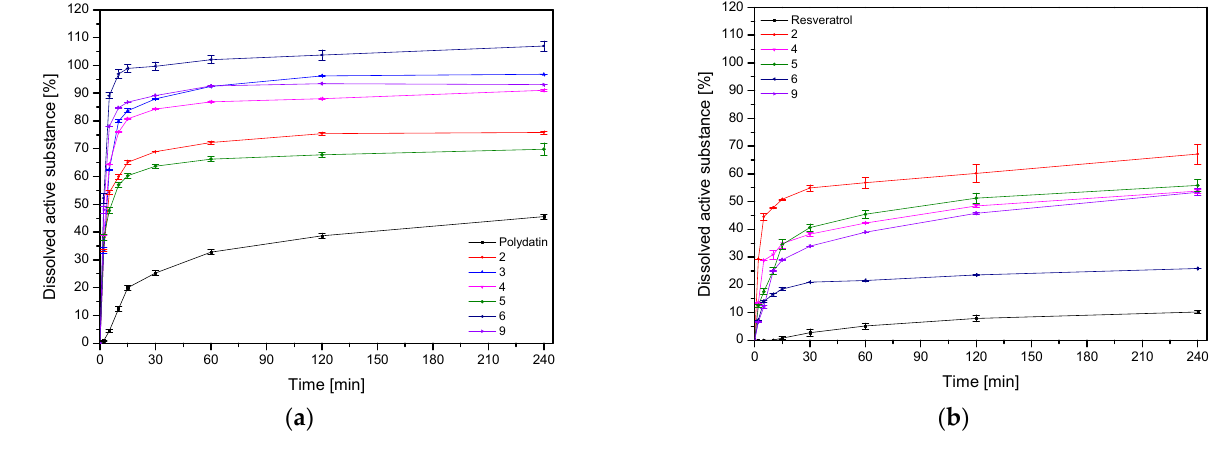
Figure 7. Dissolution profiles of polydatin ( a ) and resveratrol ( b ) from the nanofibers at artificial saliva solution at pH 6.8. Table 7. Total Amount of Released Polydatin and Resveratrol from Nanofibers at 15 Minutes.